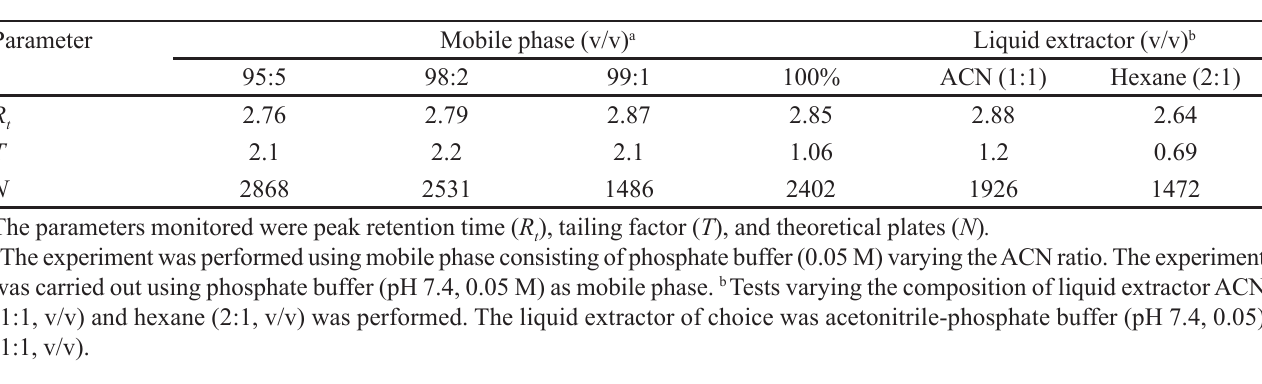
TABLE II - System suitability Parameter Mobile phase (v/v) a